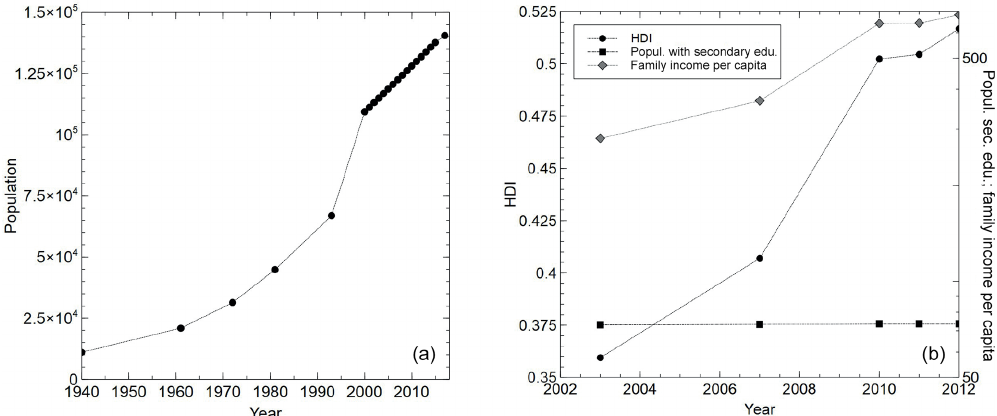
Figure 7. Population growth of Huaraz over the period 1941–2017. Data since the year 2000 are based on an extrapolation produced by the National Statistical Office of Peru (INEI) (a) . Vulnerability indicators and their changes between 2002 and 2012 for the city of Huaraz: human development index (HDI), the percentage of population with secondary education and family income per capita in Peruvian Nuevo Soles per month (data from INEI) (b)